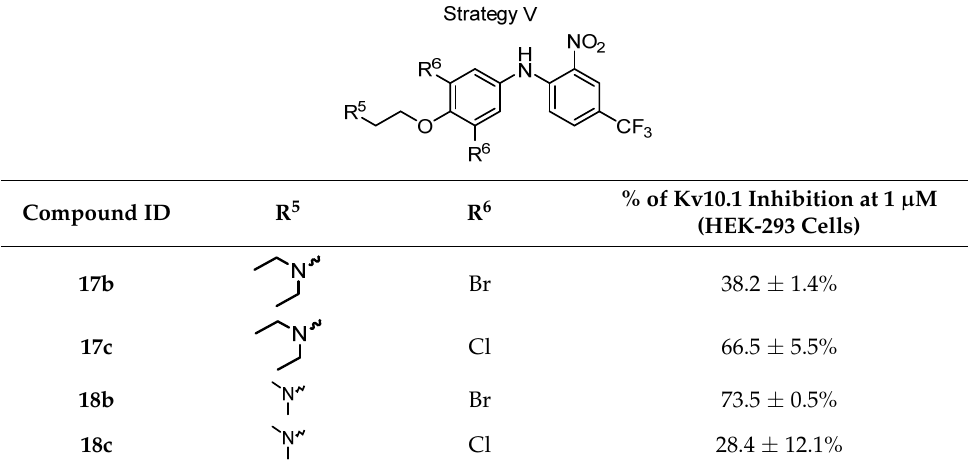
Table 5. Structures and potencies of compounds from Strategy V.